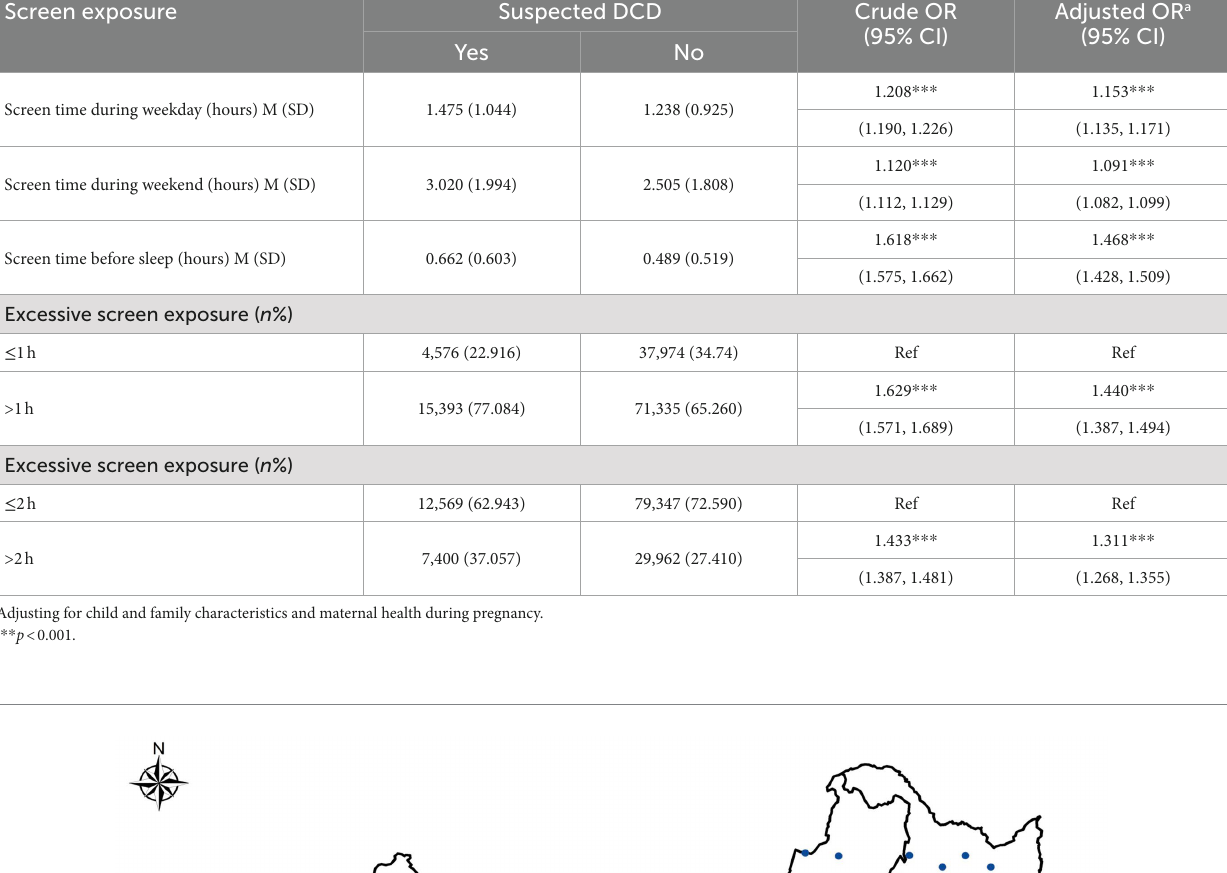
time. One possible explanation is the effect of screen exposure on melatonin. Exposure to blue light from backlit electronic screens has been found to inhibit melatonin production (51). Melatonin has been